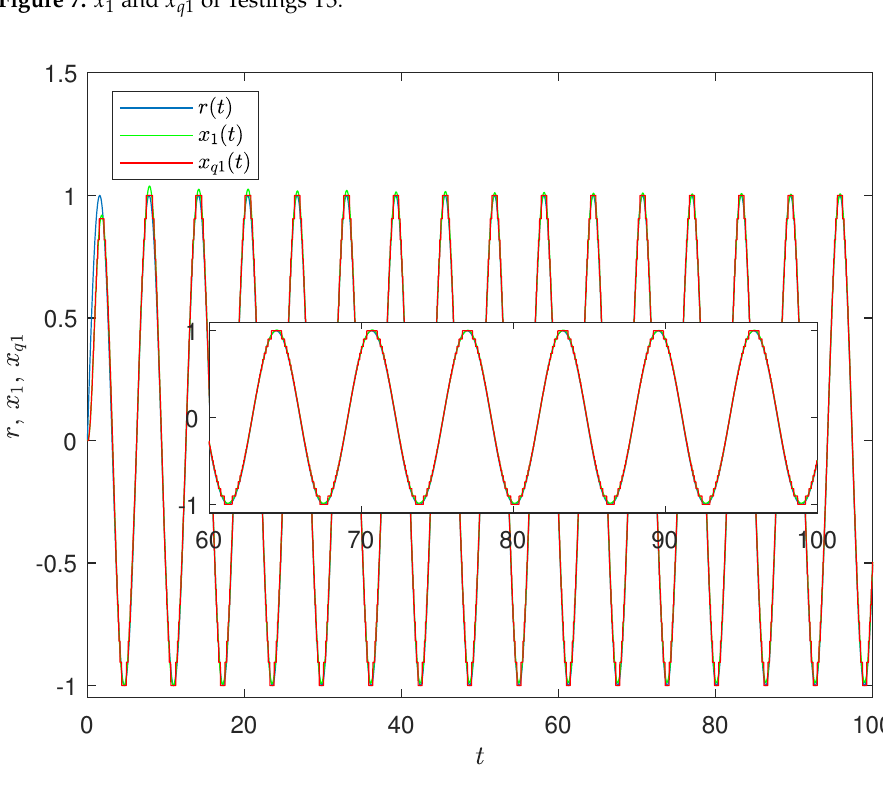
Figure 8. x 1 and x q 1 of Testings